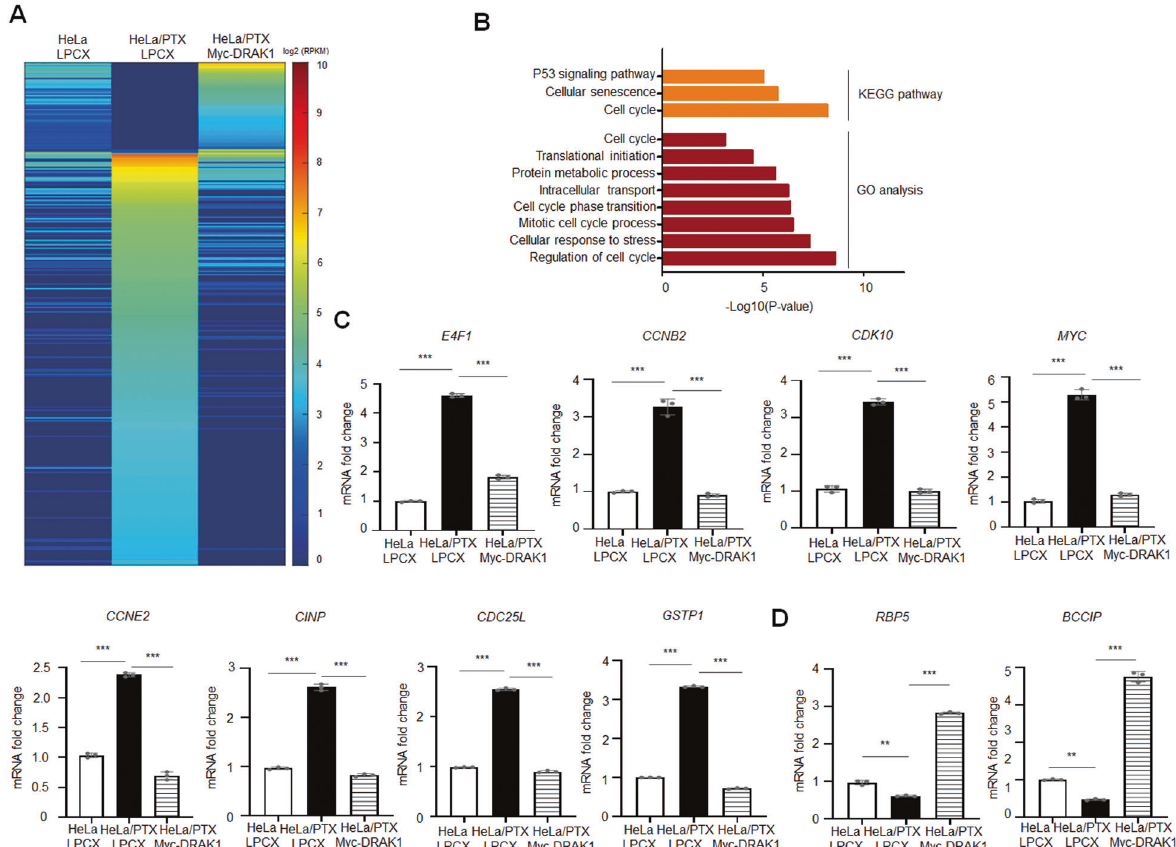
Fig. 4 Overexpression of DRAK1 downregulates the expression of cell cycle-promoting genes in paclitaxel-resistant cells. A Heatmap showing differential gene expression in DRAK1-overexpressing HeLa/PTX compared to HeLa LPCX or HeLa/PTX LPCX cells. Red represents signi fi cantly upregulated genes and blue represents signi fi cantly downregulated genes. Threshold values are as follows: corrected value P < 0.05 and absolute log2-fold change >1.0. B KEGG pathways and GO terms enriched in differentially expressed genes by DRAK1 expression from A . C qRT-PCR showing the expressions of the target genes which were downregulated by DRAK1 overexpression. D qRT-PCR showing the expressions of the target genes which were upregulated by DRAK1 overexpression. Data in C and D are representative of three independent experiments. * p < 0.05; ** p < 0.01; *** p <